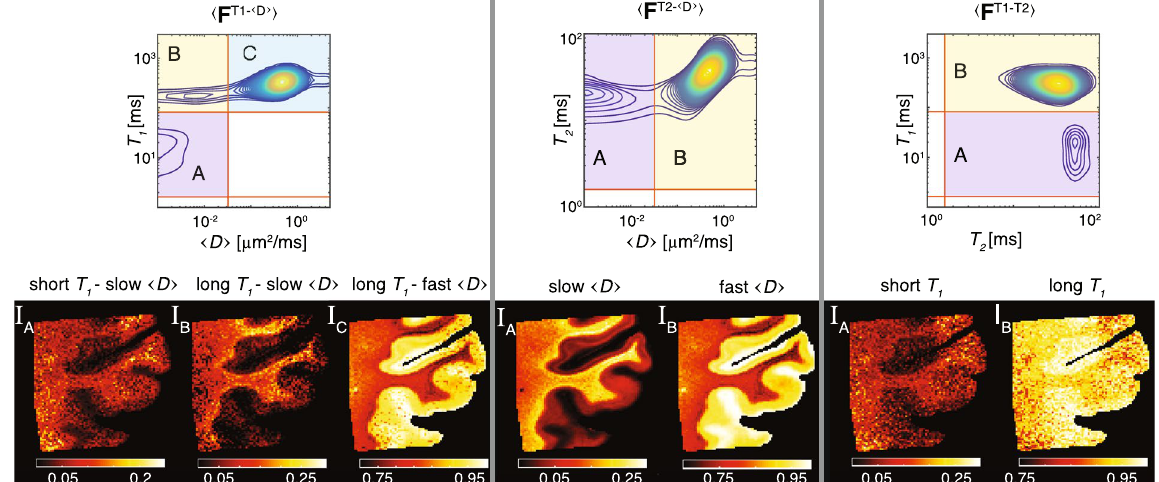
Figure 4. Conventional processing and image reconstruction of multidimensional correlation MRI data. T − D , T − D , and T − T distributions averaged across the image were used to locate the sROIs and to generate 2 1 2 the signal fraction images (left to right). Note the loss of spectral resolution that resulted in redundancy of the T dimension. Furthermore, many of the reconstructed images appear to be saturated, which implies the blending and smearing of the underlying spectral